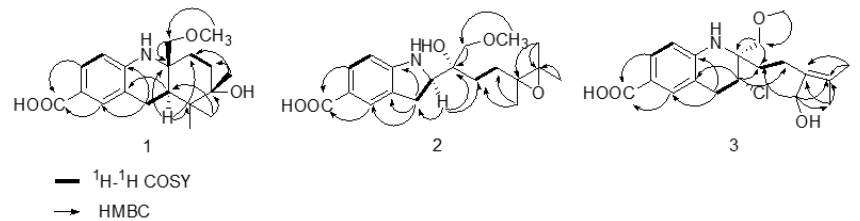
Figure 2. The key 1 H- 1 H COSY and HMBC of compounds 1 – 3.